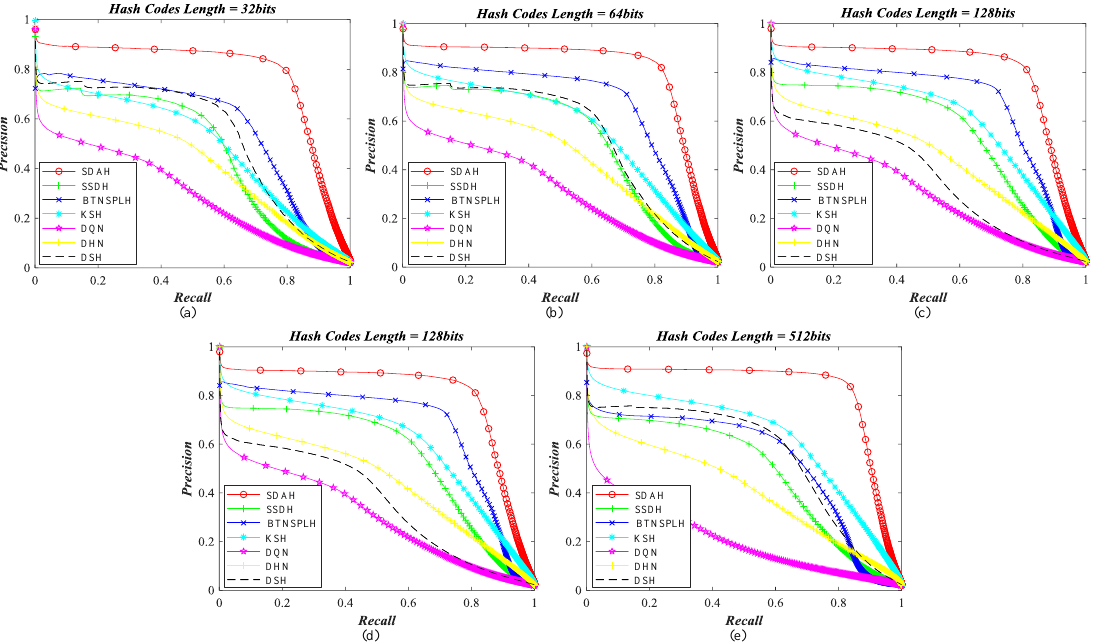
Figure 12. Retrieval precision–recall curve of different hashing methods counted on NPWU archive: ( a )The length of hash codes is 32 bits; ( b ) the length of hash codes is 64 bits; ( c ) the length of hash codes is 128 bits; ( d ) the length of hash codes is 256 bits; and ( e ) the length of hash codes is 512